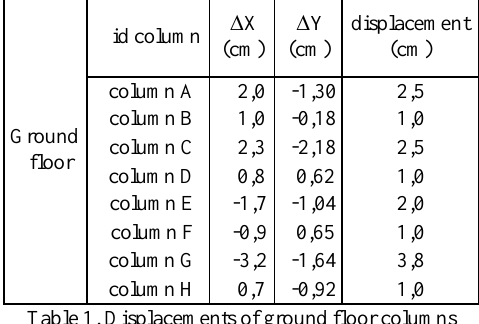
Table 1. Displacements of ground floor columns